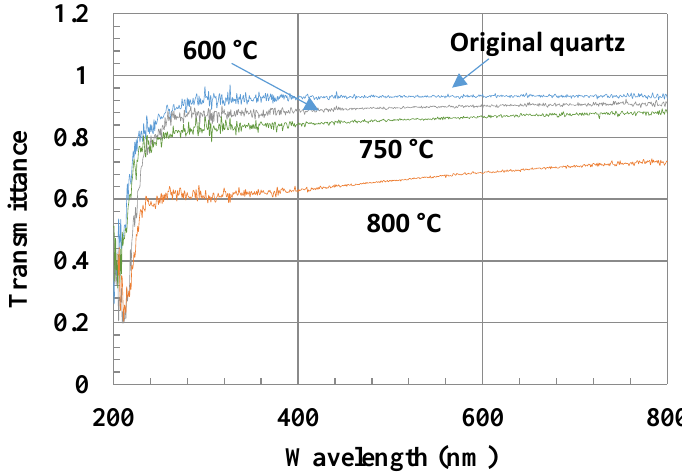
Figure 4. Transmittance spectrum of a bare quartz sample compared to C-coated quartz samples after 1 h flow of toluene at 600, 750 and 800 °C showing an increase of the absorption in the visible range resulting from the growth of the C thin film.